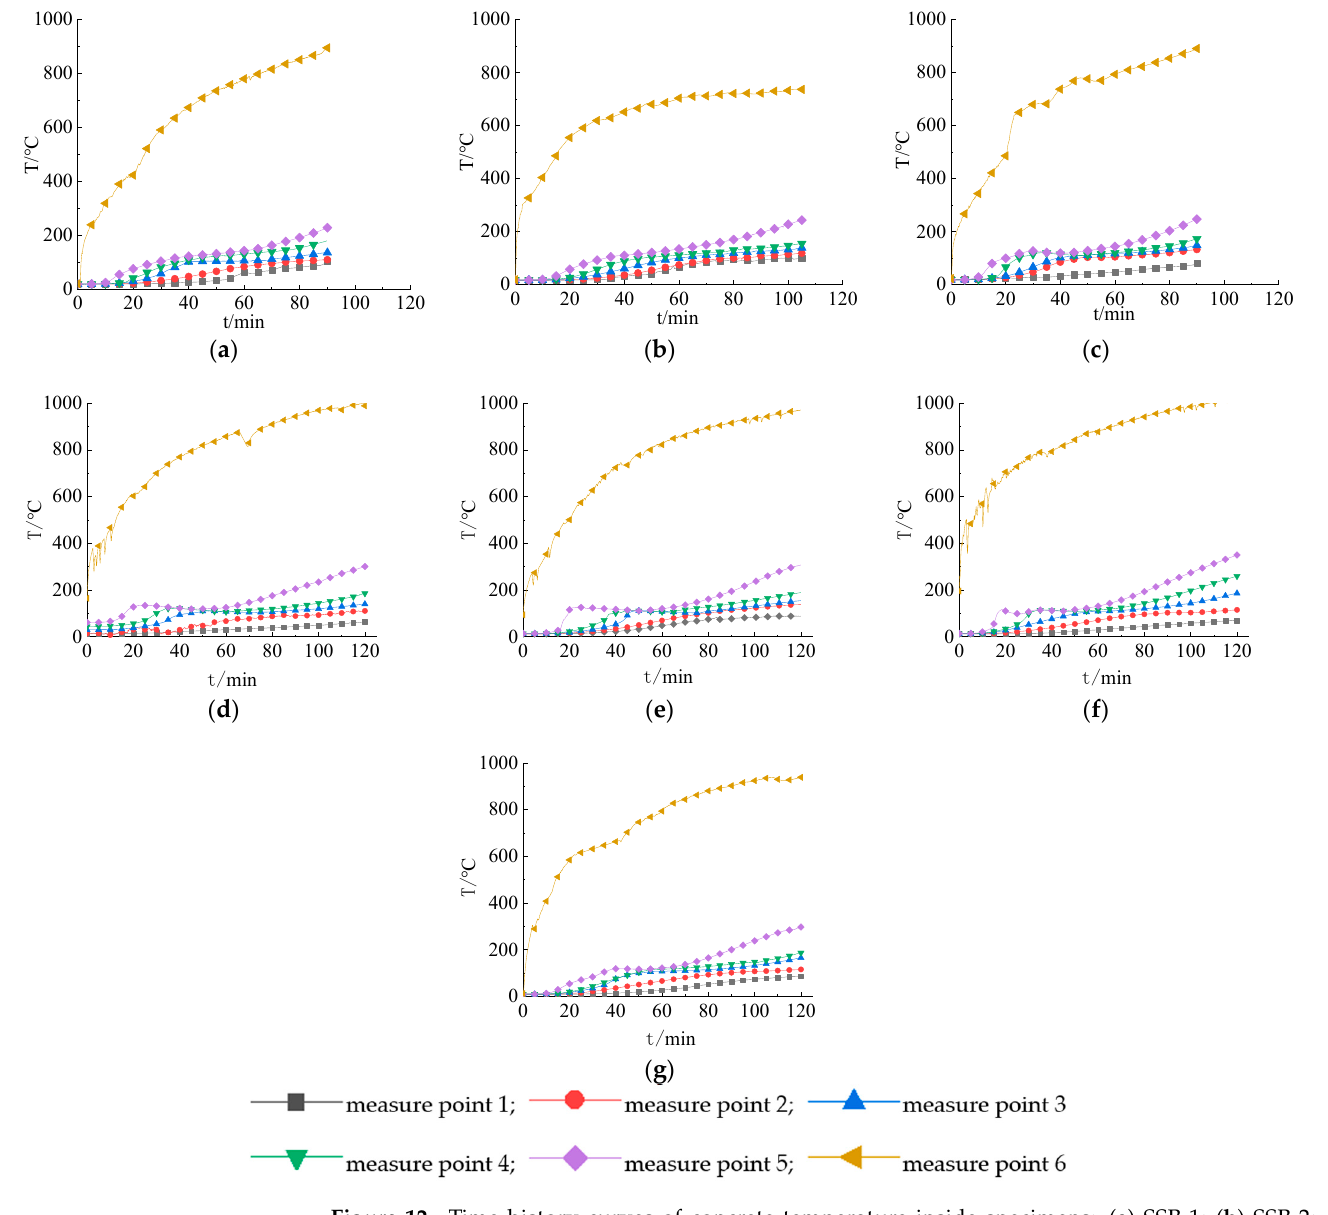
Figure 12. Time history curves of concrete temperature inside specimens: ( a ) SSB-1; ( b ) SSB-2; ( c ) SSB-3; ( d ) CB-1; ( e ) CB-2; ( f ) CB-3; ( g ) CB-4.